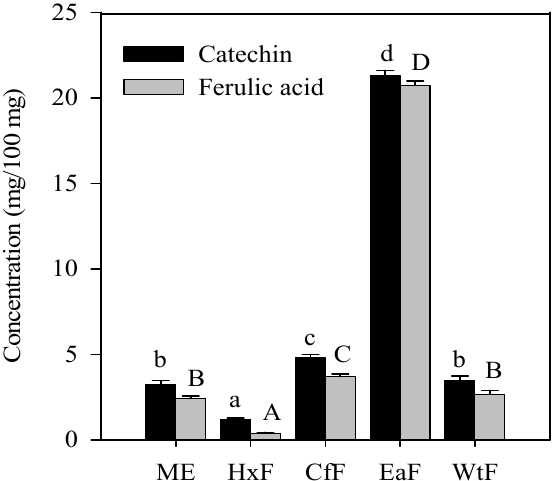
Figure 4. Concentrations of catechin and ferulic acid recovered from the methanolic extract (ME) of S . cumini leaves and its fractions. For catechin, different small letters show significant differences from each other at P < 0.05; for ferulic acid, different capital letters show significant differences from each other at P <